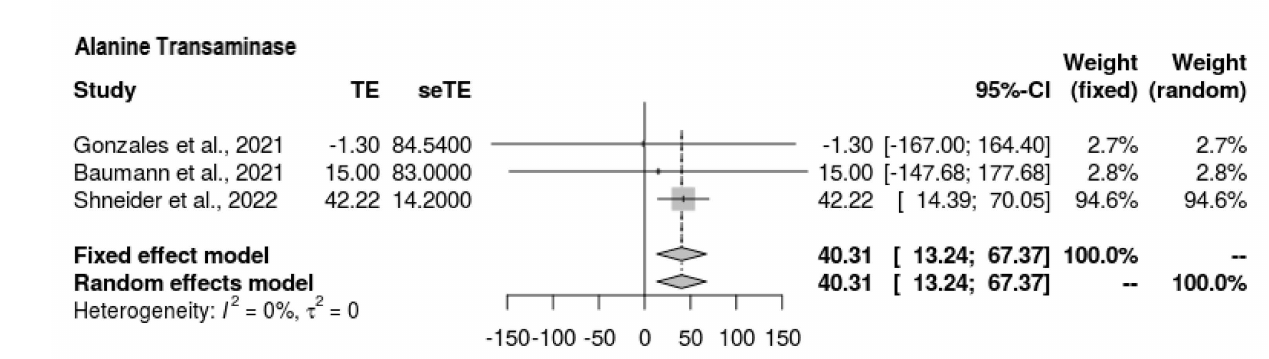
Figure 6. Forest plot representing ALT outcomes at end-line compared to baseline [19–21].